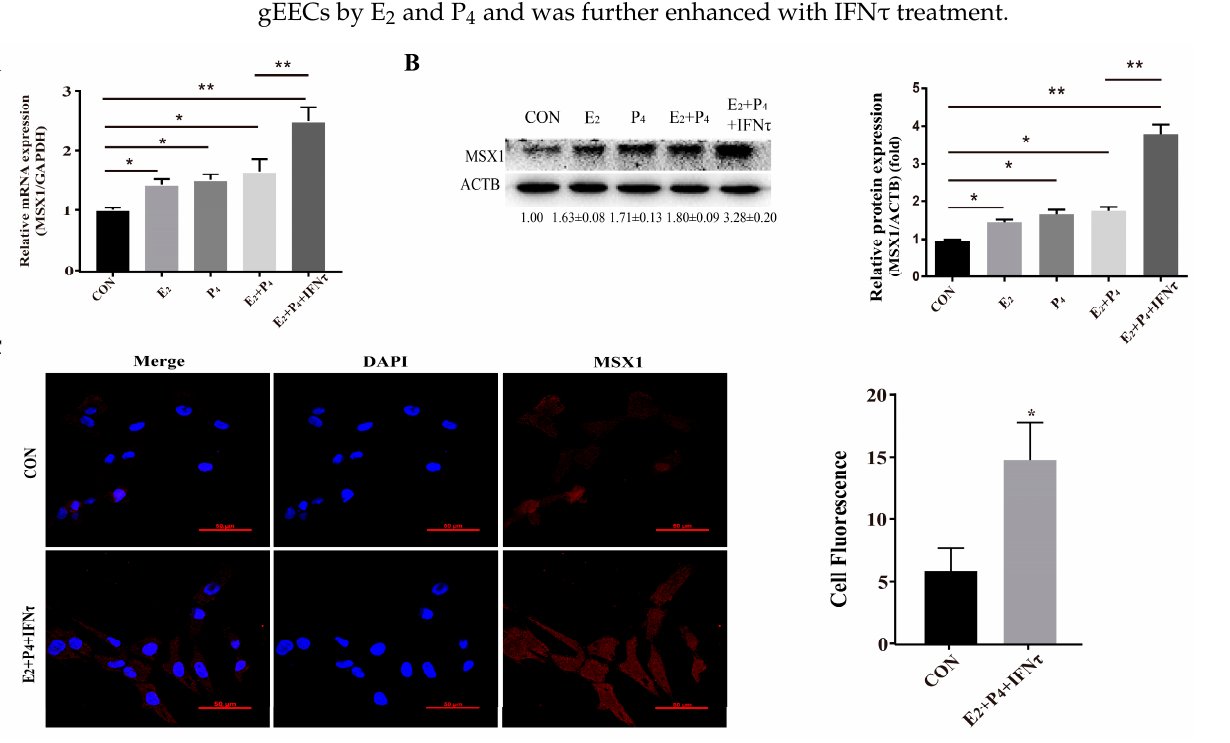
Figure 2. Hormones and/or IFN τ treatment induced MSX1 expression. ( A ) mRNA expression level of MSX1 with E 2 , P 4 , and/or IFN τ treatment; ( B ) Western blot and analysis of MSX1 protein levels with E 2 , P 4 , and/or IFN τ treatment; ( C ) representative images and analysis of the MSX1 location of gEECs in the Con and E 2 + P 4 + IFN τ groups. Scale bar = 50 μ m. * p < 0.05; ** p < 0.01.